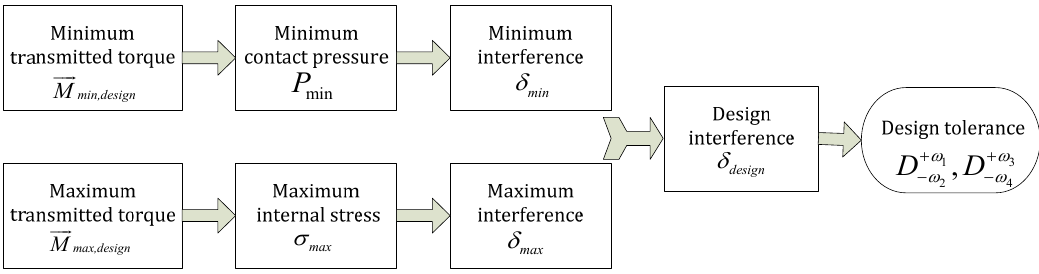
Figure1. Calculation principle for interference: based on the minimun transmitted torque and maximum internal stress in need, minimum and maximum interference are obtained by solving inverse problems, and then the design interference as well as design tolerance can be derived.